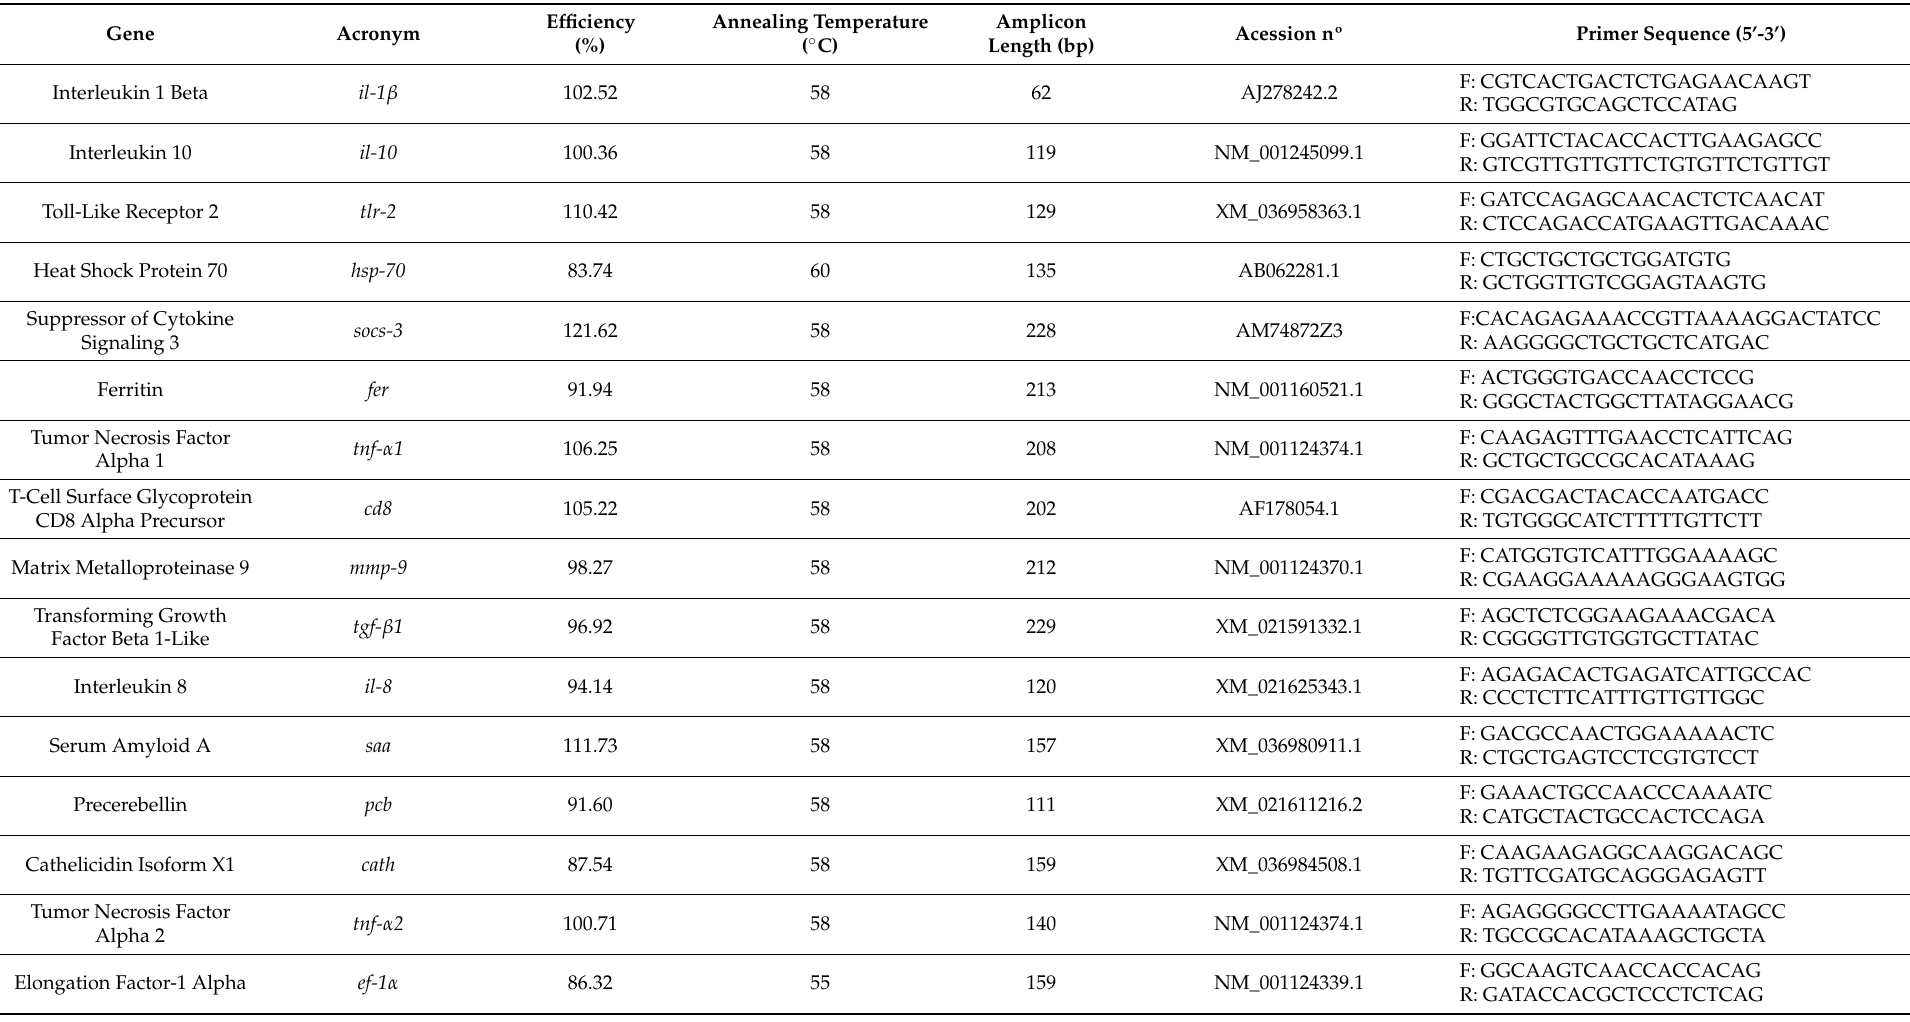
Table 1. Forward and reverse primers for real-time